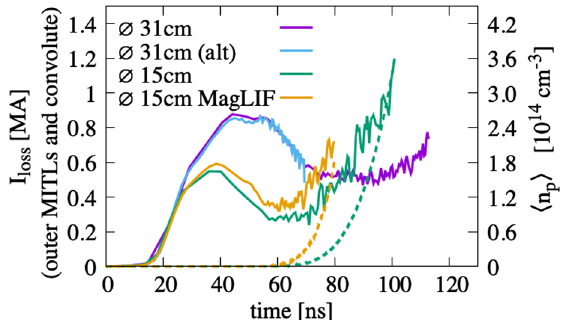
FIG. 10. The current loss in the outer MITLs and convolute for two ∅ 31 cm and two ∅ 15 cm convolute configurations. The two ∅ 31 cm examples have similar load inductances while the two ∅ 15 cm differ by 80%. Dashed lines represent the mean proton densities in the ∅ 15 cm convolutes, matched by color.